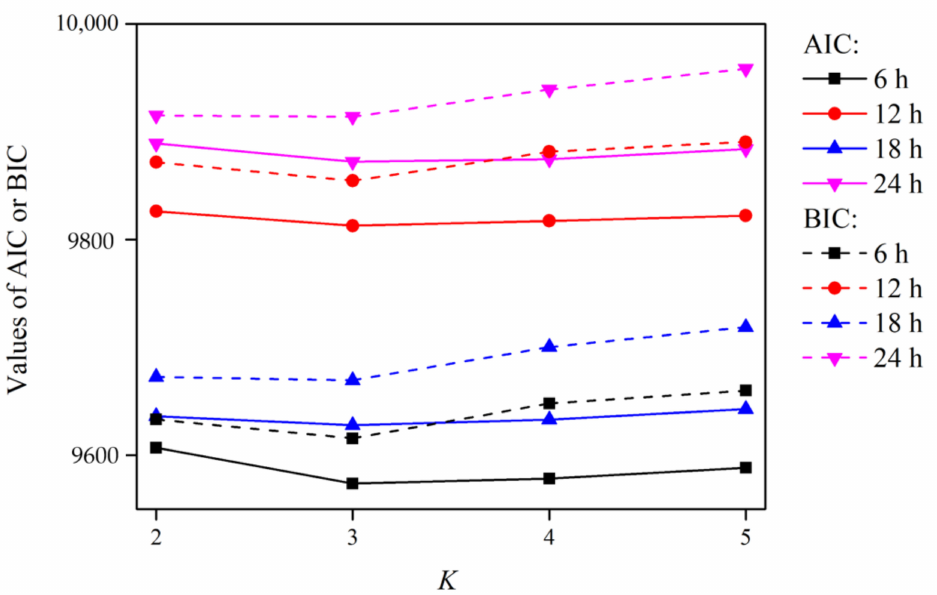
Figure 3. AIC and BIC values of the optimal IGMD-model-fitted forecast errors of multiple lead times when the Gaussian mixture number K